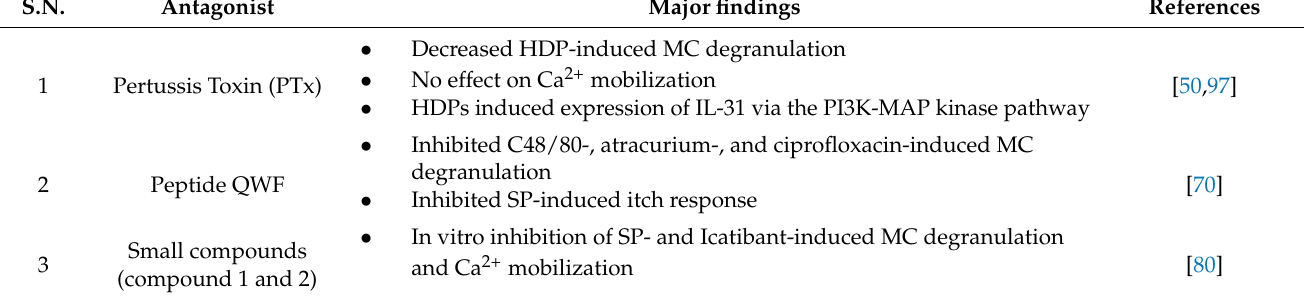
Table 2. Summary of the MRGPRX2/MRGPRB2 antagonists (peptides, small compounds and natural compounds). S.N.